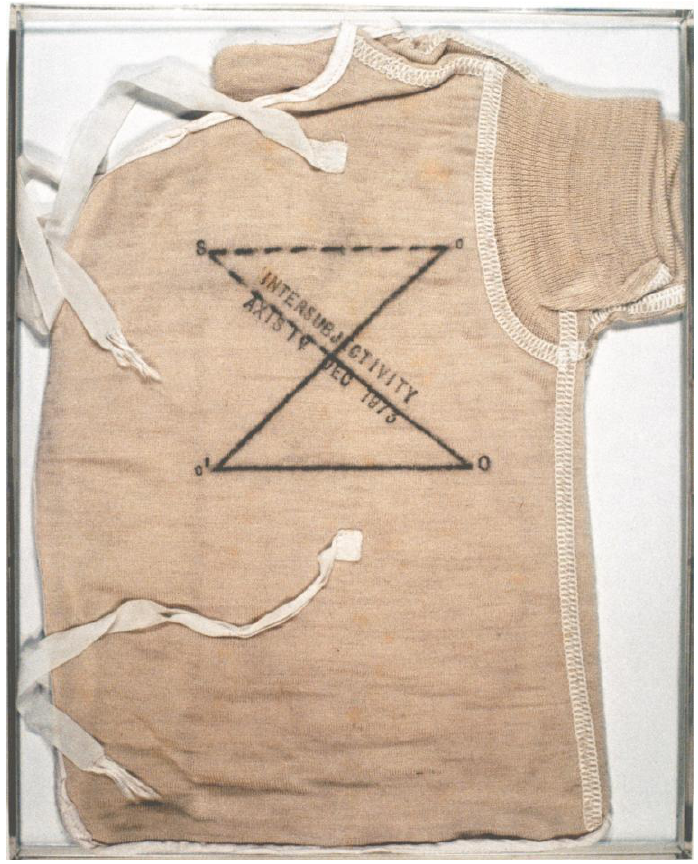
Figure 2: Mary Kelly Post-Partum Document, Introduction 1973, (detail 1 of